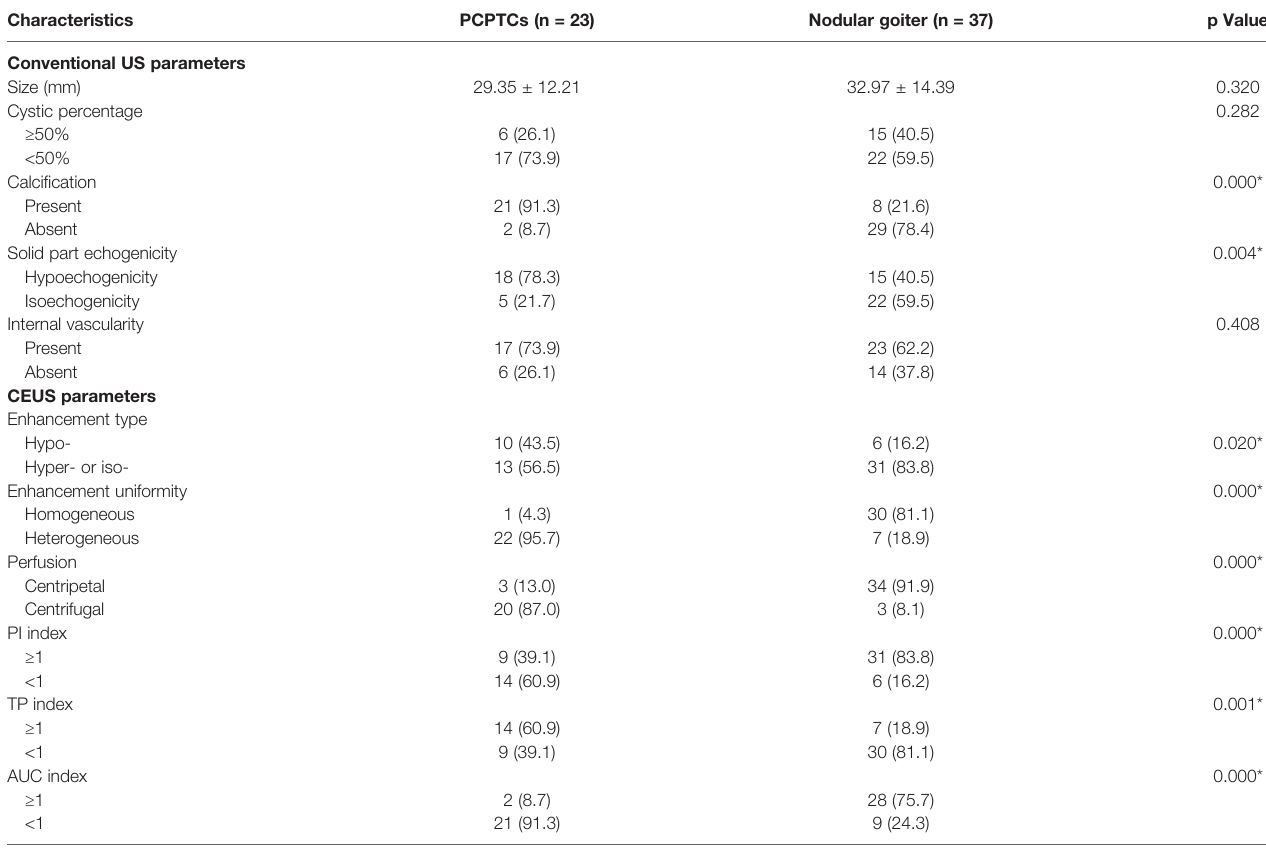
TABLE 2 | Ultrasound characteristics of the PCPTCs and nodular goiters.